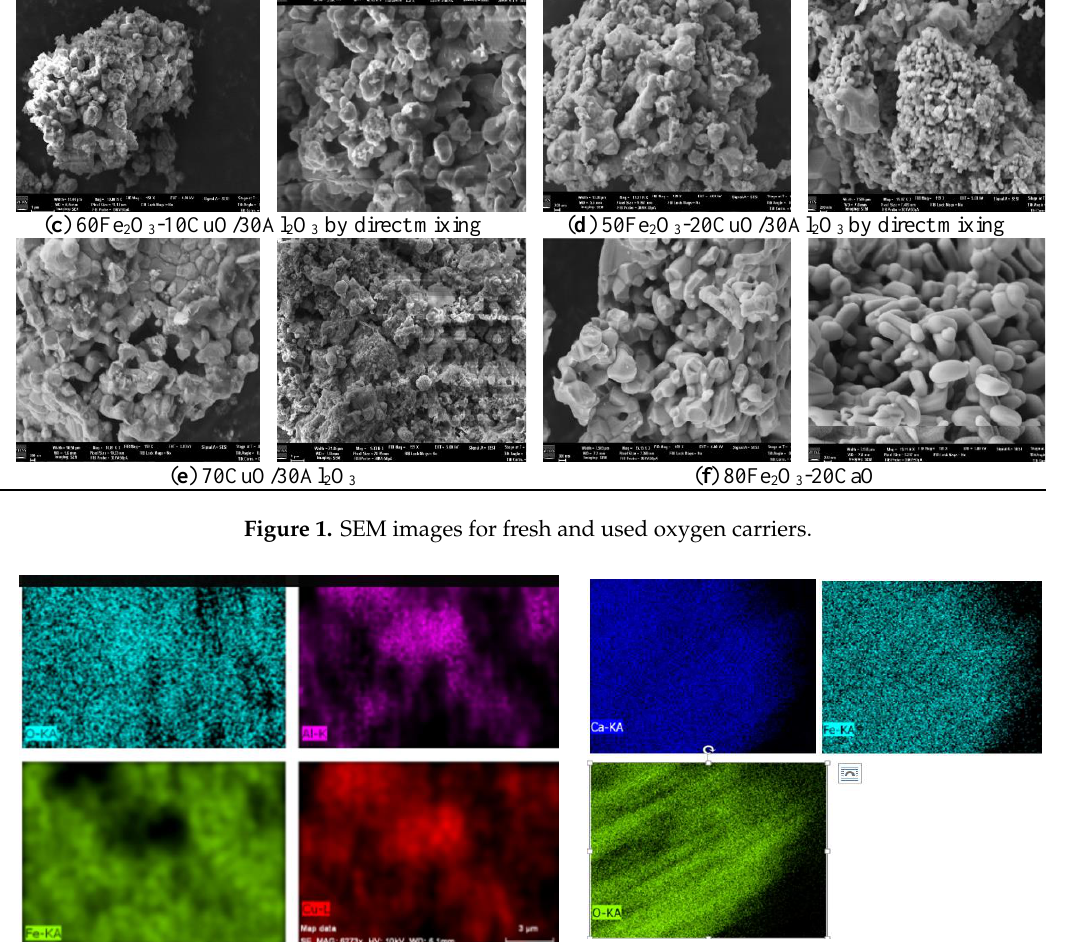
Figure 1. SEM images for fresh and used oxygen carriers.